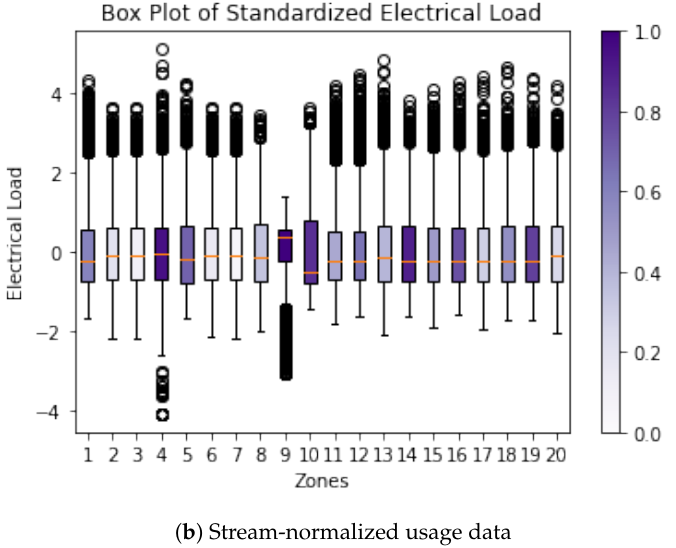
Figure 12. Box plot of stream data.